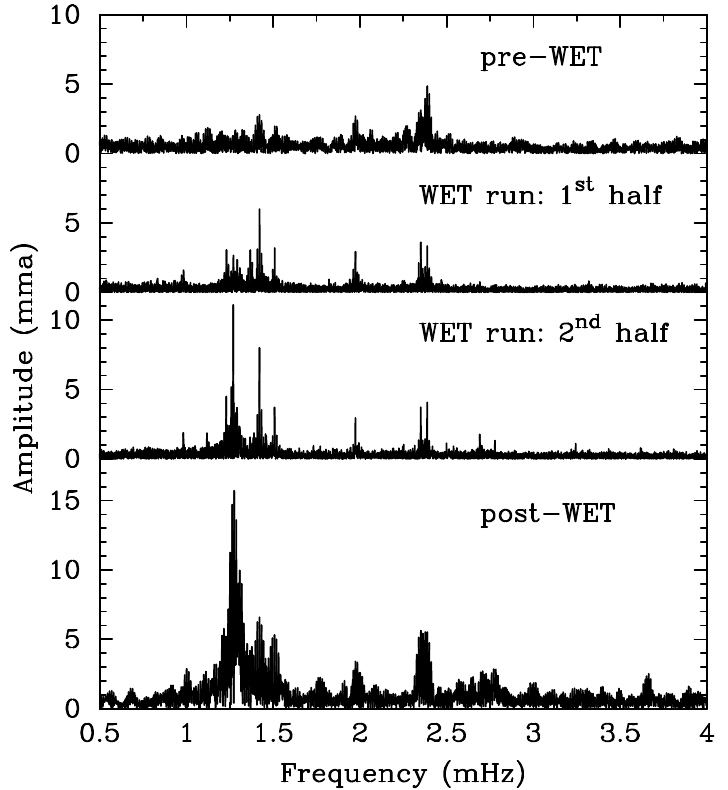
Fig. 6. Fourier amplitude spectra of the XCov22 observations of PG 1456+103, together with those of pre-WET measurements (observer E. Romero-Colmenero at SAAO) and post-WET data (observers M. A. Wood and R. P. Perrine with SARA). This figure is based on on-line reductions and will be